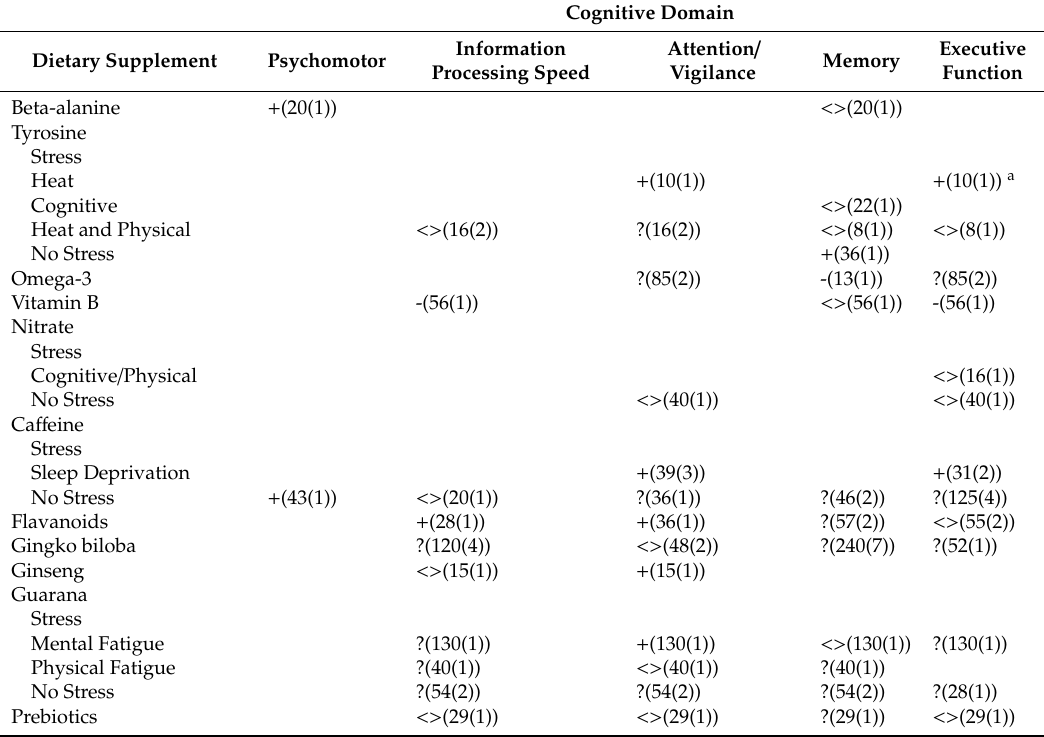
Table 5. Summary of impacts of reviewed dietary supplements on cognitive domains (# of participants (# of studies)). Improvement ( + ), decrease (-), no change ( <> ), or uncertain